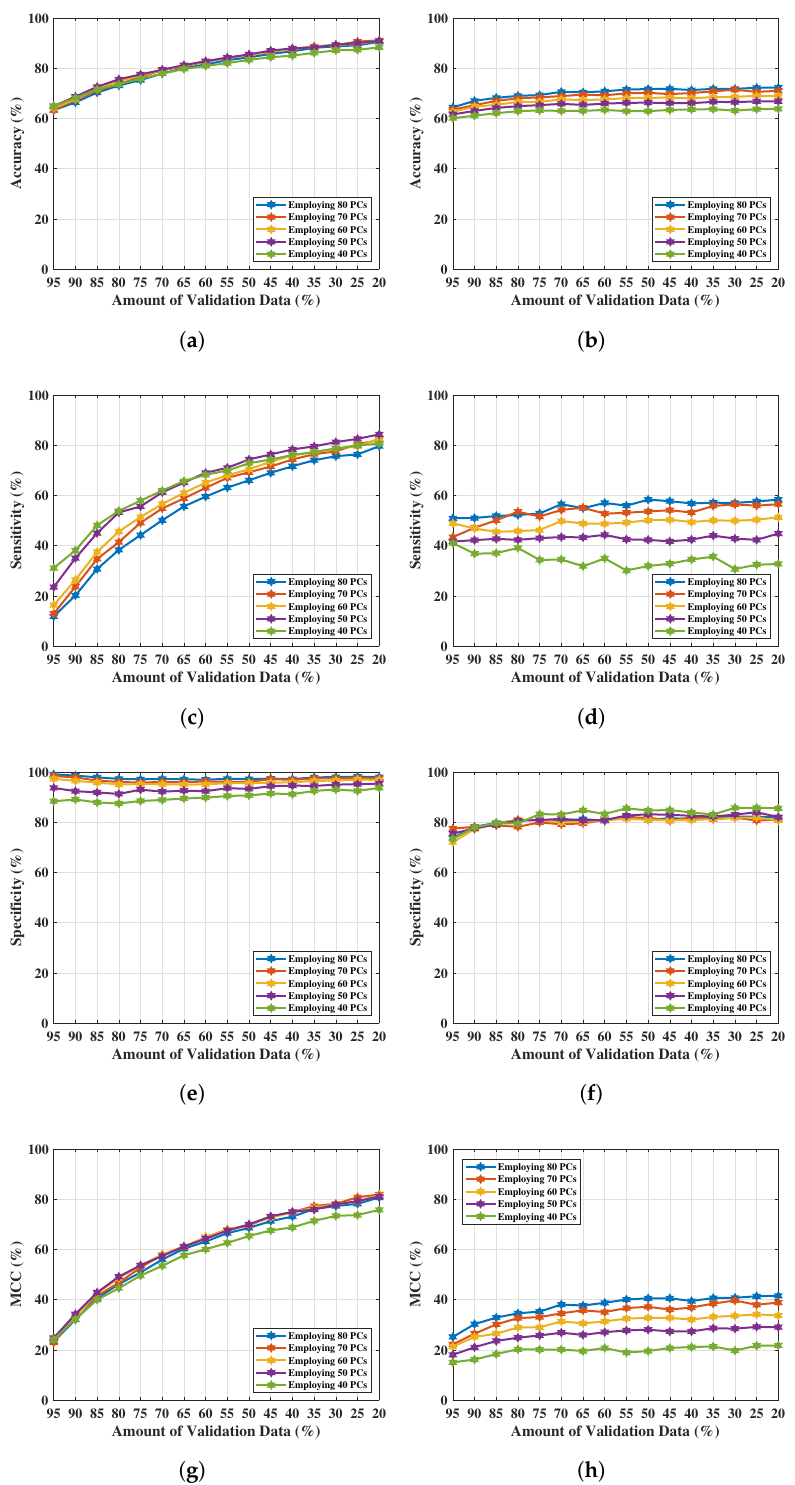
Figure 5. NF and WF signal classification results obtained from SVM Q and SVM G applying PCA over MammoWave’s complex S 21 data. ( a ) Accuracy obtained from SVM G varying PCs and vali- dation data. ( b ) Accuracy obtained from SVM Q varying PCs and validation data. ( c ) Sensitivity obtained from SVM G varying PCs and validation data. ( d ) Sensitivity obtained from SVM Q varying PCs and validation data. ( e ) Specificity obtained from SVM G varying PCs and validation data. ( f ) Specificity obtained from SVM Q varying PCs and validation data. ( g ) MCC obtained from SVM G varying PCs and validation data. ( h ) MCC obtained from SVM Q varying PCs and validation